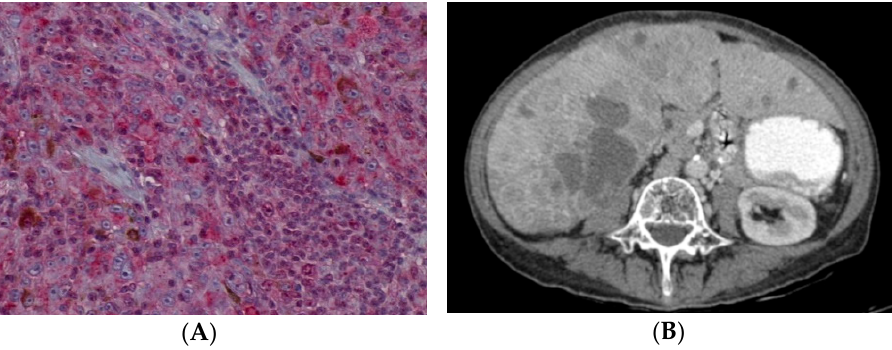
Figure 7. ( A ) Low grade nuclear BAP1 staining in a patient who died due to uveal melanoma metastasis. ( B ) Liver metas- tasis in an axial slice of a computed tomography